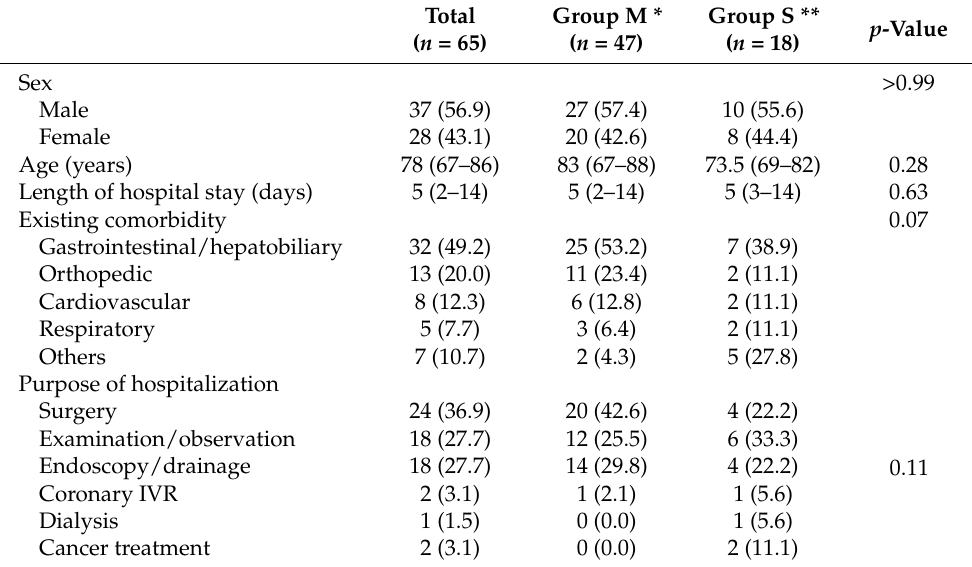
Figure 1. Flow chart of the study. Table 2. Patient